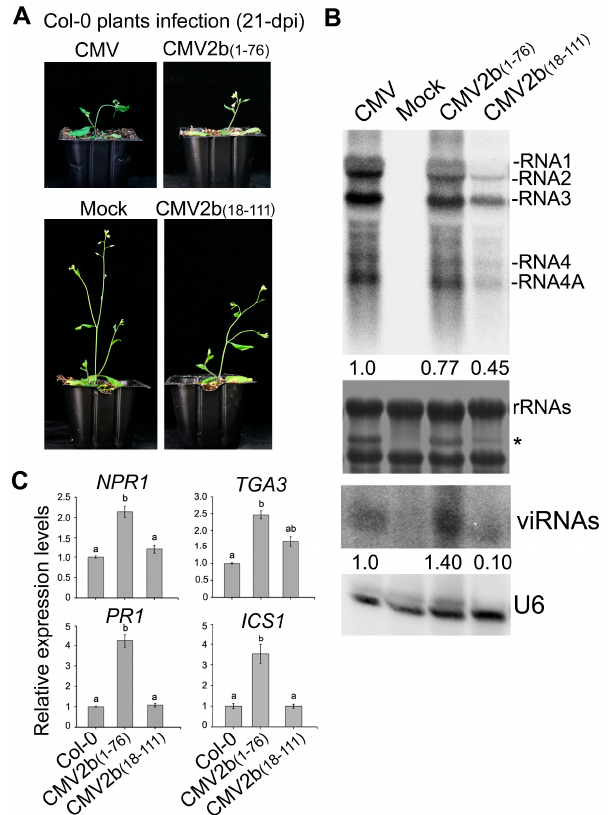
Figure 8. Pathogenicity and the relative expression of genes in SA pathways in CMV2b (1–76) - and CMV2b (18–111) -infected plants. ( A ) Disease symptoms and ( B ) viral RNAs and sRNA accumulation (21 dpi). * a stained viral RNA used as an indicator of CMV infection. viRNAs represented virus-derived siRNAs. The values below referred to the relative hybridization signal intensity of RNA 3 and viRNAs measured for each sample with the accumulation level in WT plants set as 1. ( C ) Virus-induced expression of defensive genes. Means identified by different letters are significantly different from each other. Error bars represent SEs from three biological replicates. One-way ANOVA followed by Tukey’s multiple comparisons test, was used for statistical analysis ( P < 0.05).